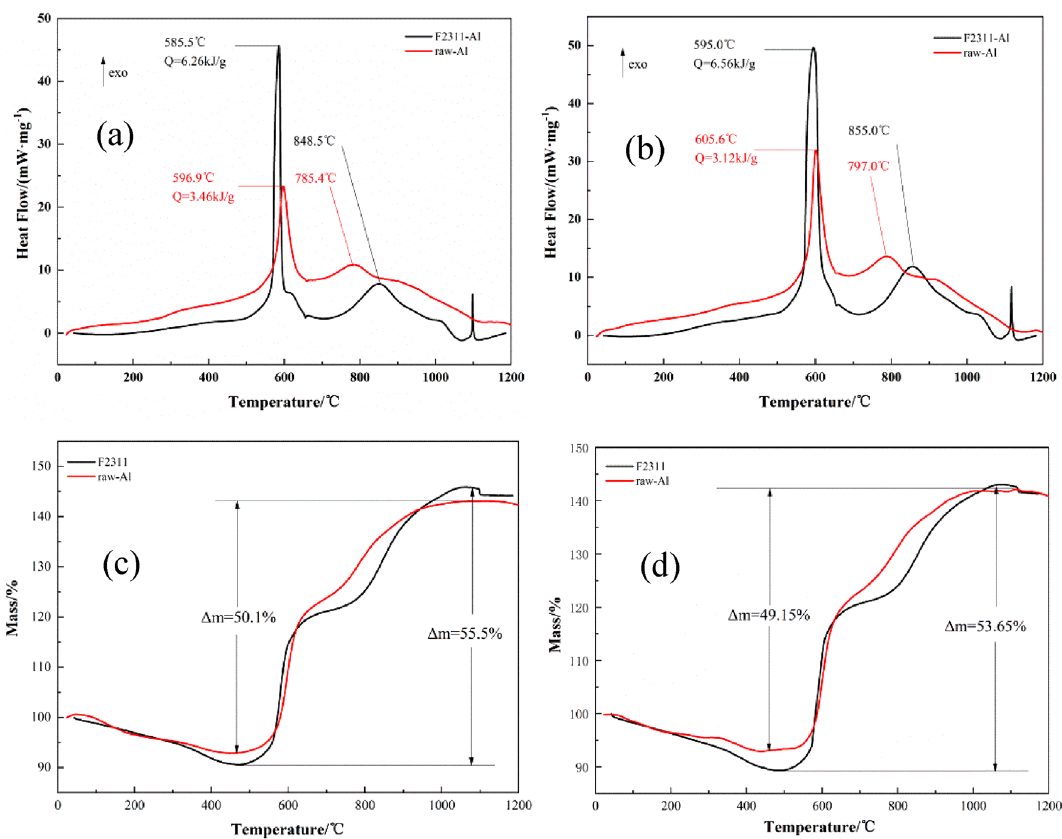
Figure 8. TG/DSC curves of F2311@Al and ordinary Al at different heating rates: ( a ) 10 °C/min-DSC; ( b ) 15 °C/min-DSC; ( c ) 10 °C/min-TG; ( d ) 15 °C/min–TG.